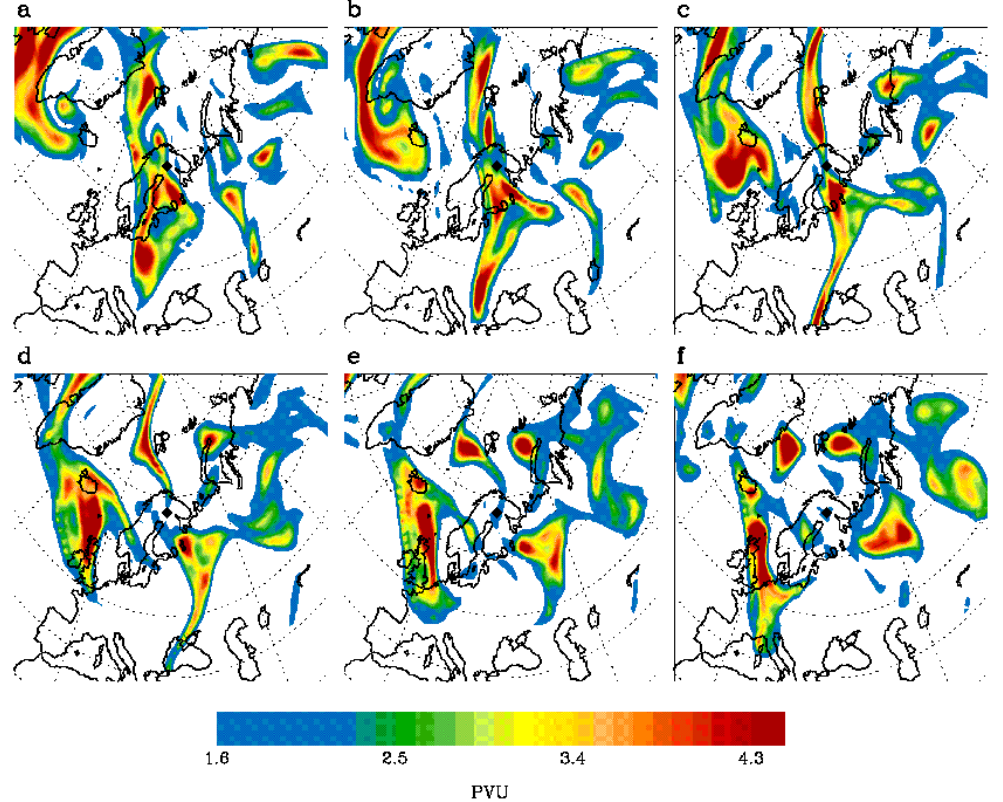
Fig. 5. PV charts calculated for the 295K isentropic surface at (a) 12:00UTC on 14 February; (b) 00:00UTC (c) 12:00UTC on 15 February (d) 00:00UTC (e) 12:00UTC on 16 February (f) 00:00UTC on 17 February. Sodankyl¨a is marked with a diamond. Only PV > 1.6PVU is